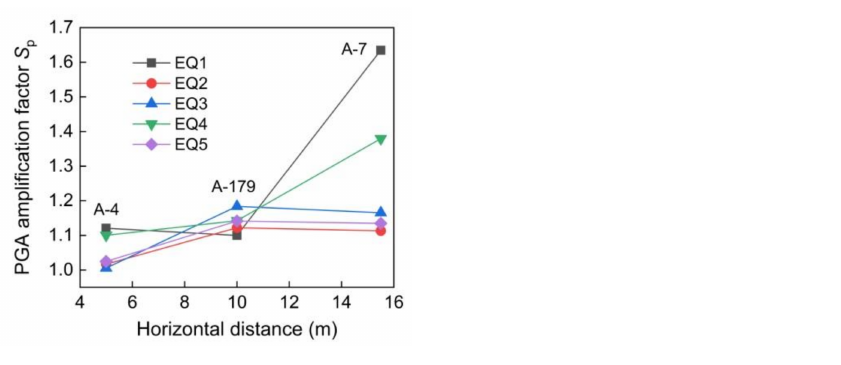
Figure 7. The horizontal acceleration amplification factor distribution from the inside of the slope to the surface of the slope at a height of 15.8 m in the 2# model in centrifuge tests.